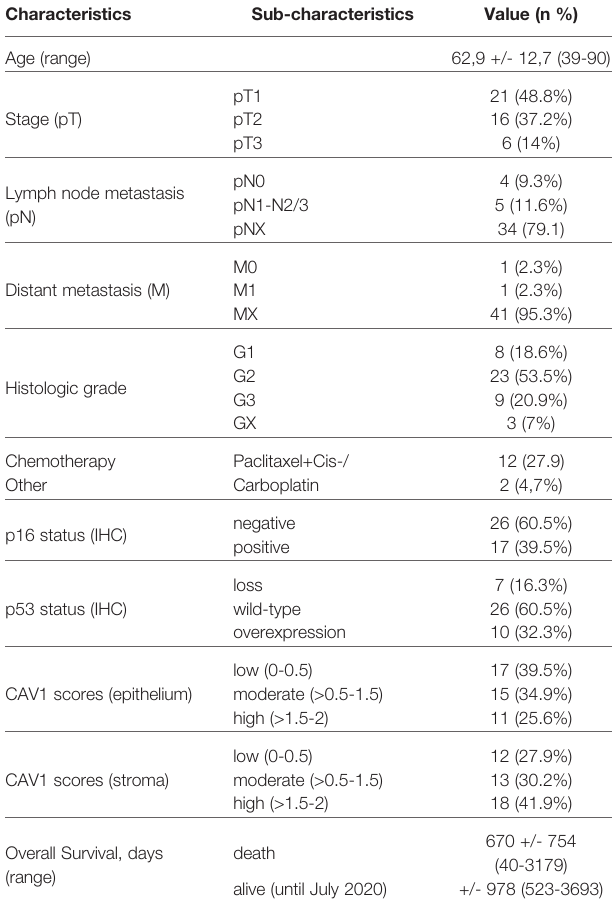
TABLE 1 | Baseline patient demographics and histopathology (n = 43). 29 patients underwent partial amputation surgery (local excision and destruction of diseased tissue) or total penis amputation (14). The smoking status was